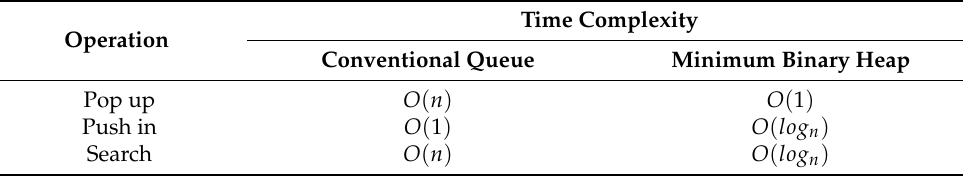
Figure 6. Data storage of binary heap. Table 2. Time complexity for conventional priority queue and minimum binary